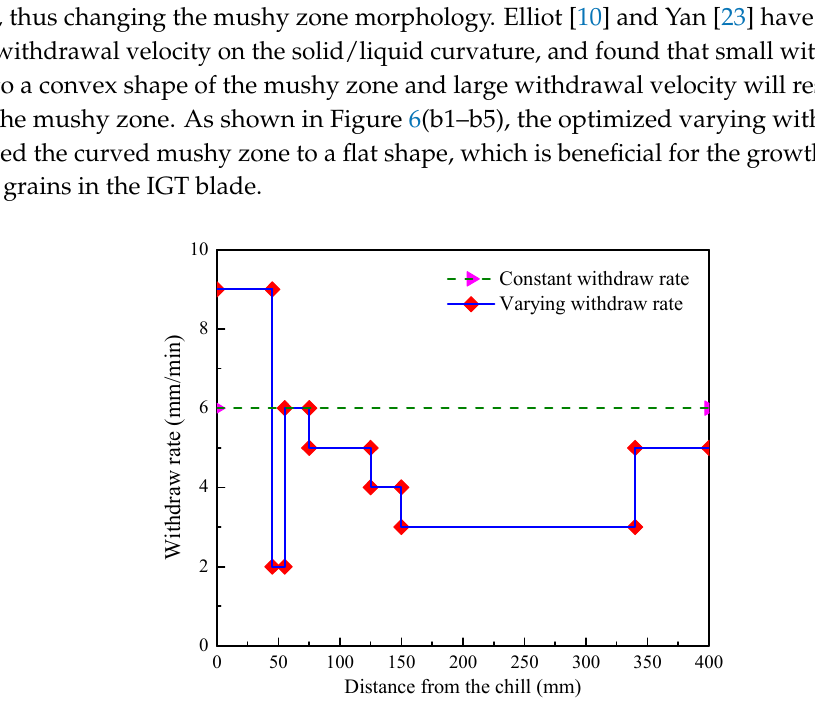
Figure 5. The constant and varying withdrawal rates that are applied to an IGT blade during the LMC process.